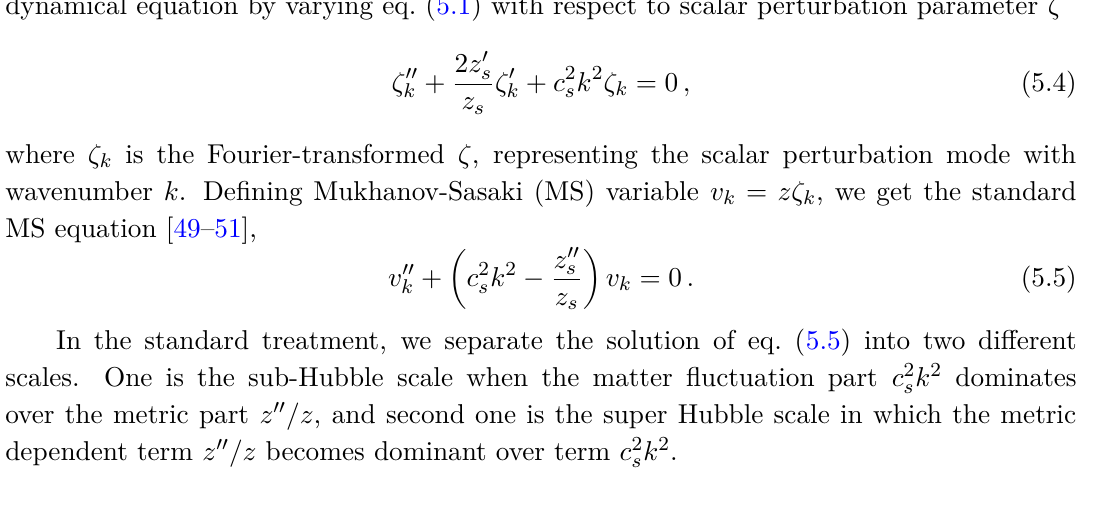
Figure 4. The dynamics of z 2 the right panel) as a function of cosmic time t . The positivity of z 2 We also show the approximated behavior of c 2 to 1 / 3 at the far future by a pink dash